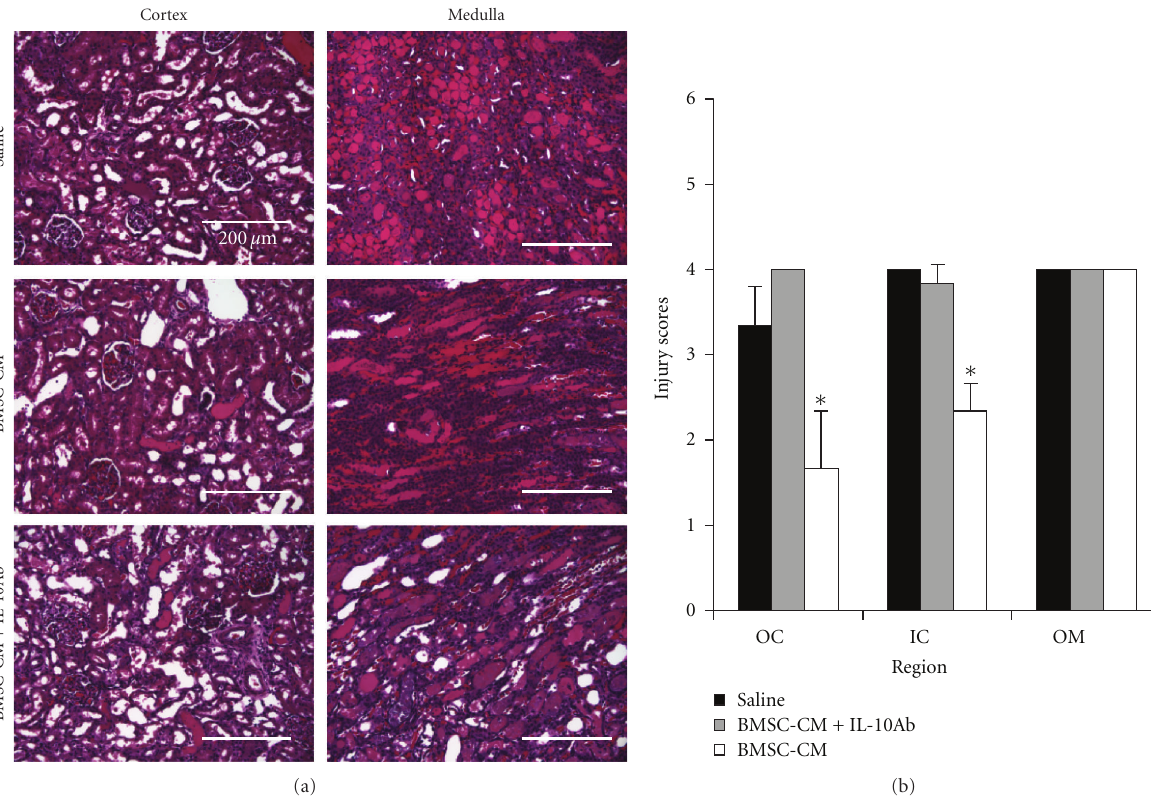
Figure 8: IL-10 antibody reduces the tissue sparing capacity of BMSC-CM . (a) H&E histological analysis of kidneys from cisplatin-treated rats administered either BMSC-CM plus a neutralizing IL-10 antibody ( n = 3), BMSC-CM ( n = 3), or saline ( n = 3). Animals were sacrificed at 5 days after cisplatin for tissue harvesting. (b) Quantification of tissue injury in the outer cortex (OC), inner cortex (IC), and outer stripe of the outer medulla (OSOM) for rats treated with either BMSC-CM plus a neutralizing IL-10 antibody, BMSC-CM, or saline. Scale bar = 200 μ m. ∗ P < 0 . 05 by Student’s t -test.